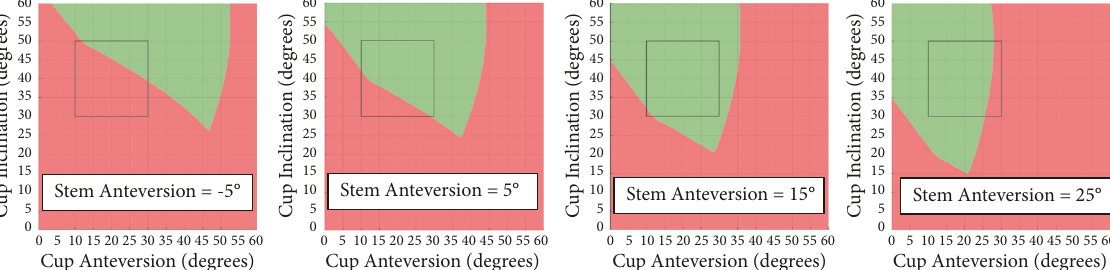
Figure 5: Impingement with different stem anteversion for Stem 2.